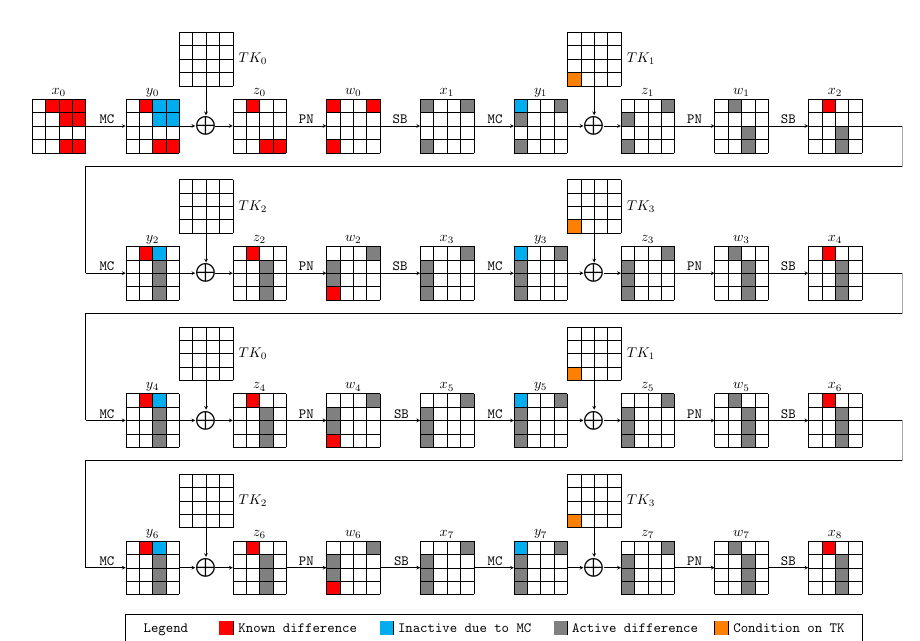
Figure 3: A truncated differential trail of